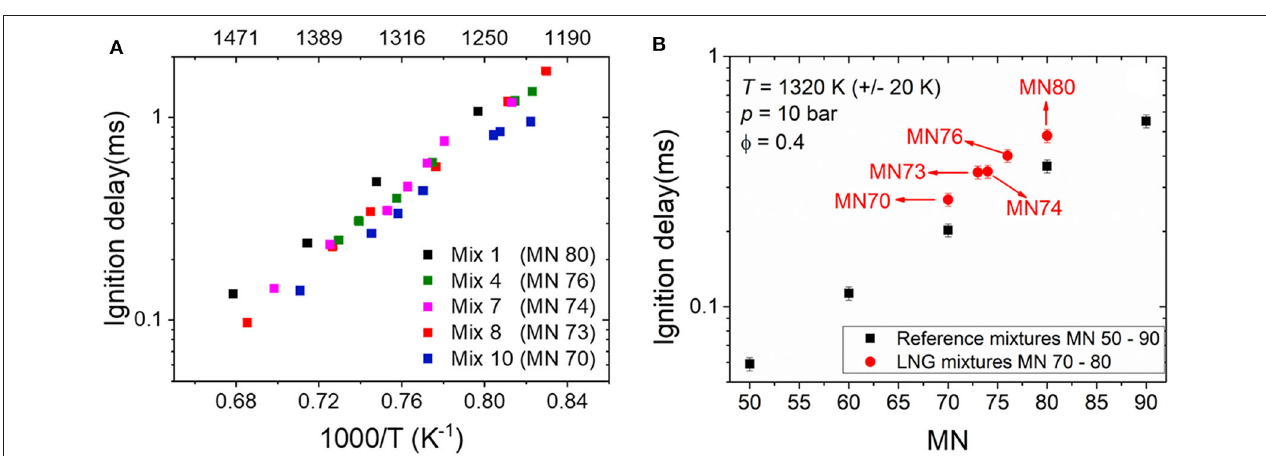
Frontiers in Mechanical Engineering |